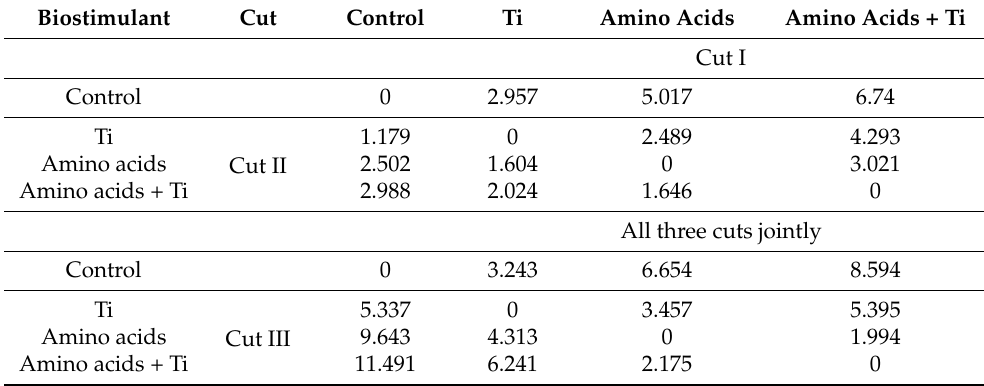
Table 4. The values of the Mahalanobis distances for all pairs of biostimulant treatments in cut I, cut II, cut III, and all three cuts